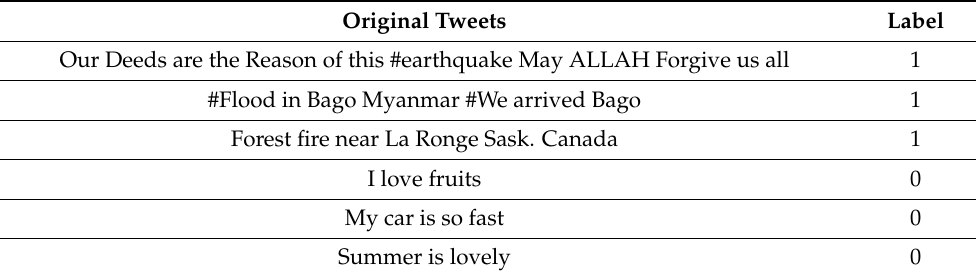
Table 2. Sample tweets from the Kaggle disaster dataset (1—Disaster; 0—Non-disaster). Original Tweets Label